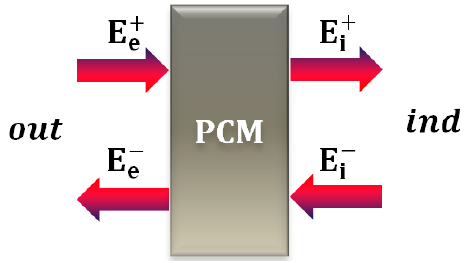
Figure 2. Energy entering and energy exiting through the external surface, E + e and E − e , and through the internal surface, E + and E − , of the PCM layer. i i